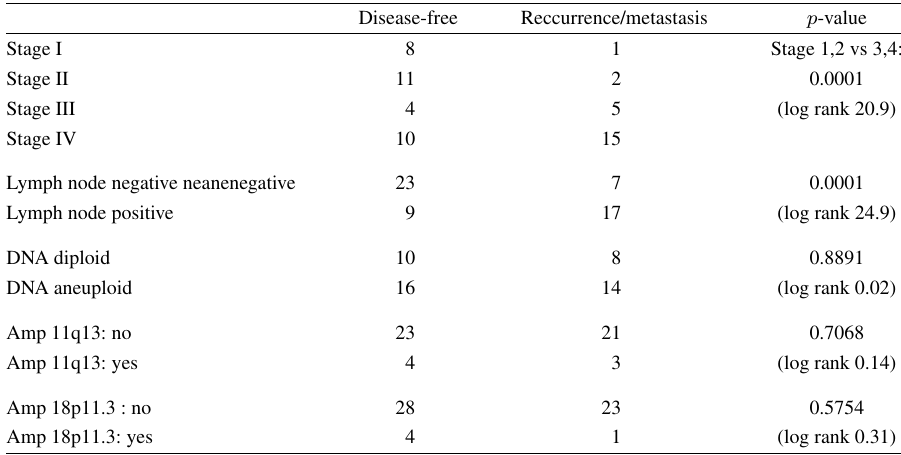
Clinical and genetic characteristics in relation to disease-free survival Disease-free